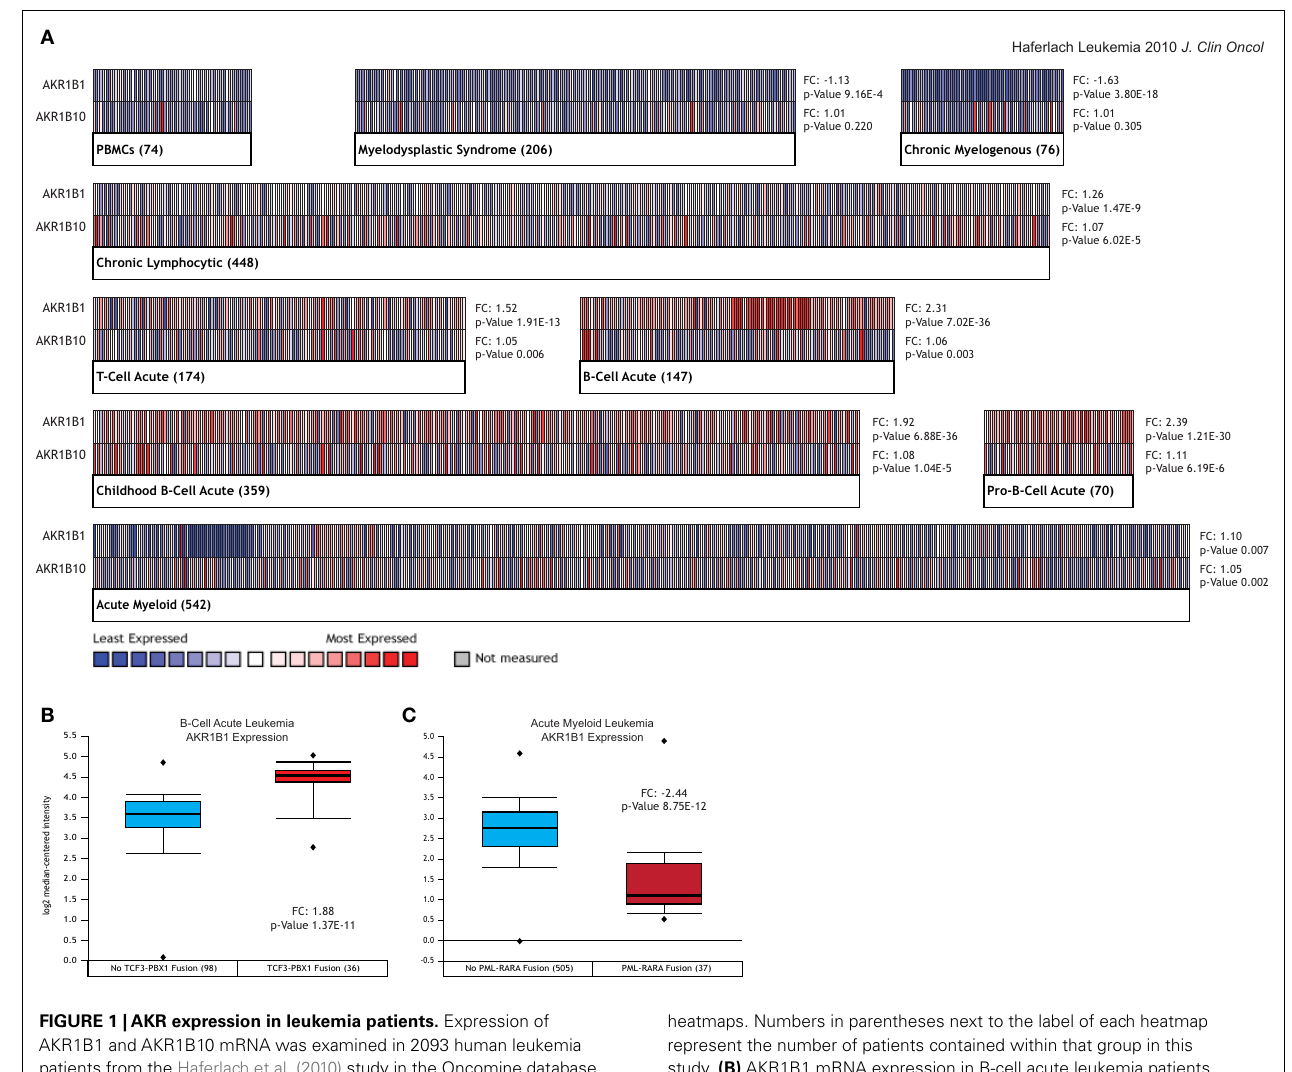
FIGURE 1 |AKR expression in leukemia patients. Expression of AKR1B1 and AKR1B10 mRNA was examined in 2093 human leukemia patients from the Haferlach et al. (2010) study in the Oncomine database. (A) Heatmap display of AKR1B1 (top rows) and AKR1B10 (bottom rows) expression within the indicated leukemia types. Fold changes relative to peripheral blood mononuclear cells (PBMCs) and p -value for that comparison within each leukemia type are listed next to their respective